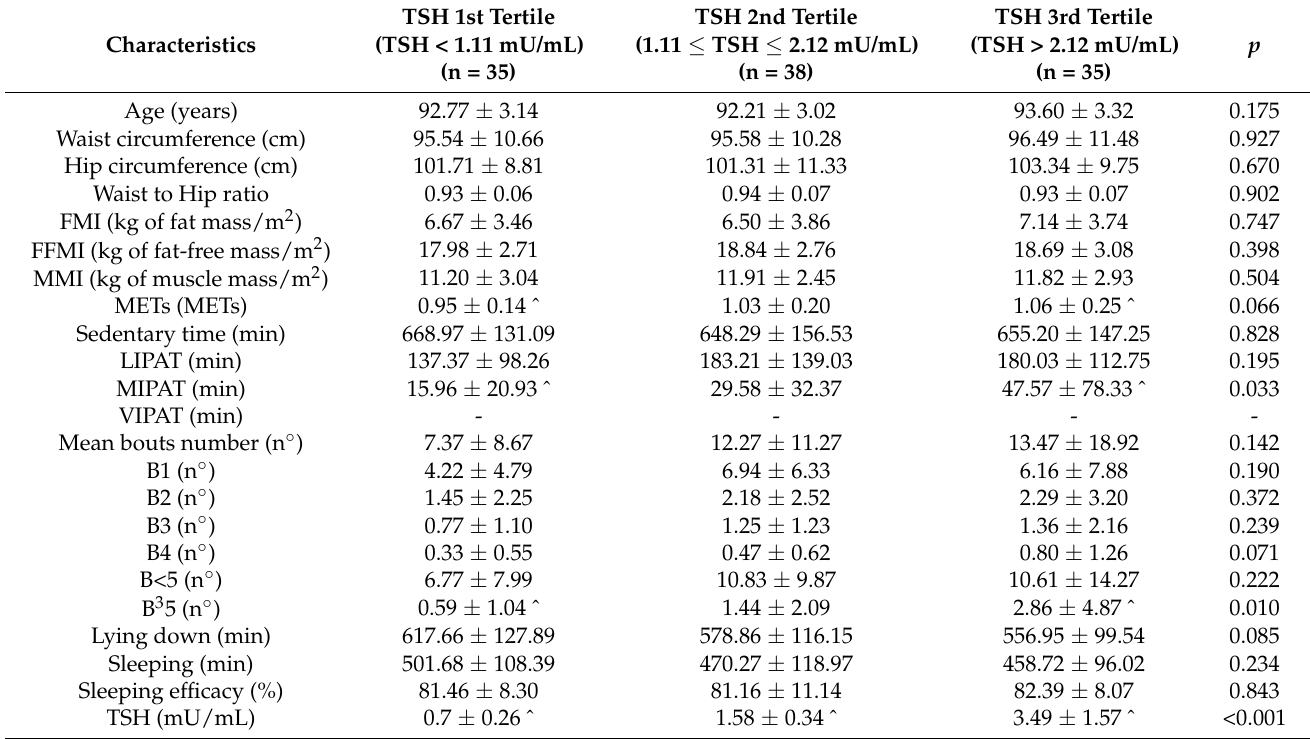
Table 3. Comparisons of sub-samples characteristics, according to TSH tertile memberships, using the one-way analysis of variance and Bonferroni test, as post hoc